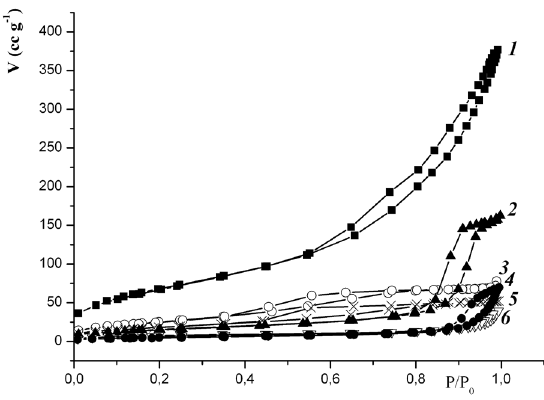
Figure 4. Isotherms of nitrogen adsorption-desorption for different TiO : amorphous − ■ (1), anatase+brookite − ▲ 2 (2), anatase − ○ (3), brookite − ● (4), rutile − × (5), anatase+rutile− ∇